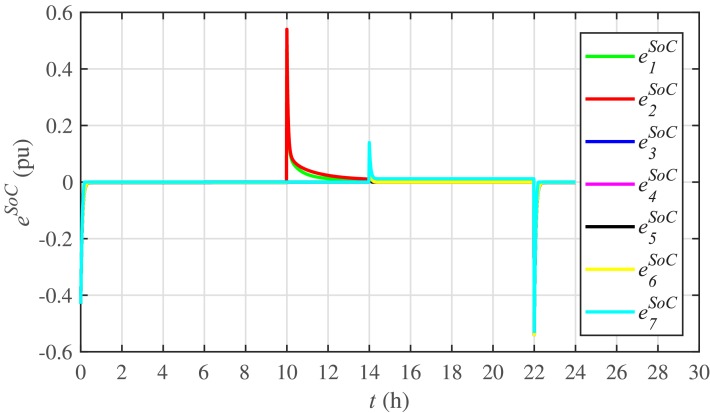
SoC tracking errors under case 5. [27].